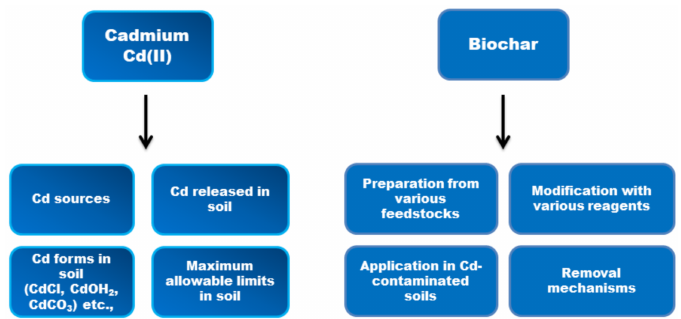
Figure 1. Summary of the main content of this review article. Table 1. Summary of review papers published since 2020 on the preparation, characterization, and potential application of biochar and biochar-based materials for the restoration of soil polluted with metal